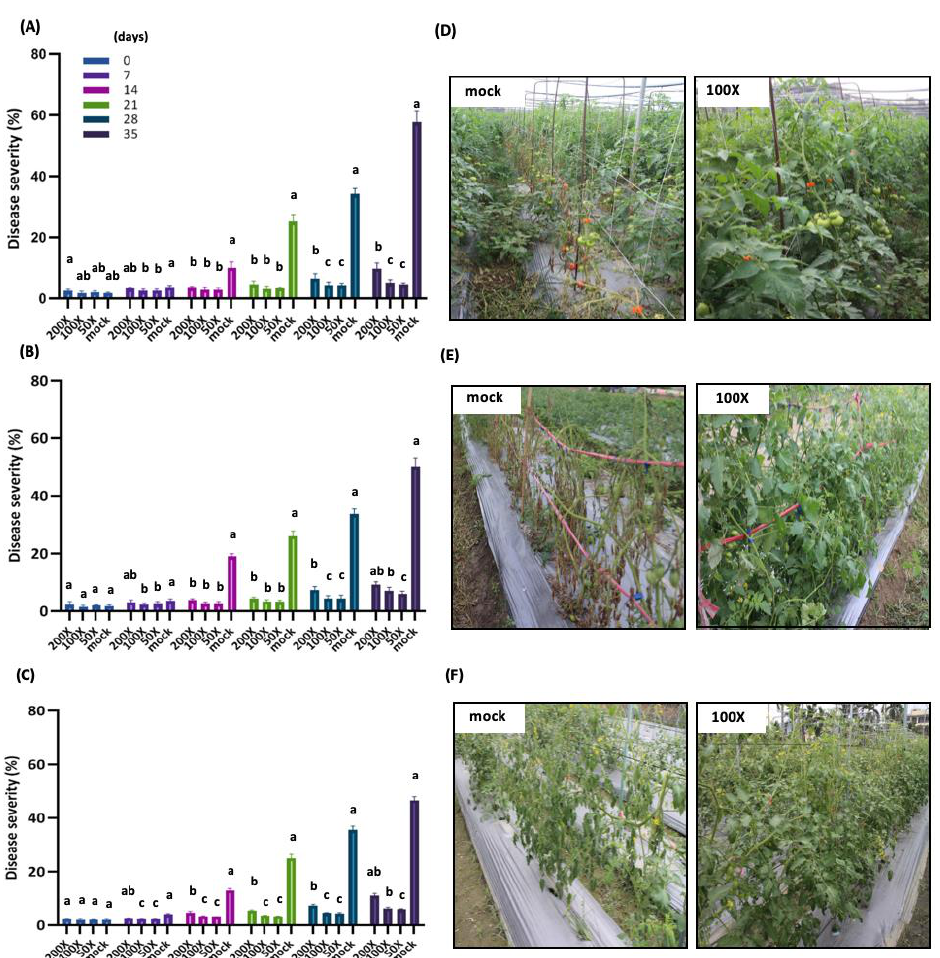
Figure 5. Field trials evidencing the Bacillus amyloliquefaciens PMB01 strain’s effectiveness in con- trolling bacterial wilt disease in three tomato farms. Bacterial wilt disease caused by Ralstonia solanacearum occurred regularly in these farms. ( A ) The disease severity of bacterial wilt on TMB-688 tomato variety planted in Ren-Wu District in 2014. ( B ) The disease severity of bacterial wilt on Yu Nu tomato variety grown in A-Lian District in 2015. ( C ) The disease severity of bacterial wilt on Golden Sweet tomato variety grown in Mei-Nong District in 2016. Tomato plants were treated with PMB01 wettable powder (WP) at 200X, 100X, 50X, or water (mock control) every week for five consecutive weeks. Disease severity was determined on days 0, 7, 14, 21, 28 (last treatment of PMB01), and 35 in each trial. Means within the columns followed by different letters are significantly different according to Tukey’s HSD analysis ( p < 0.05). Images of tomato plants after being treated with water (mock) or PMB01 wettable powder at 100X on day 35, showing the effectiveness of PMB01 in controlling bacterial wilt in tomato farms located in Ren-Wu ( D ), A-Lian ( E ), and Mei-Nong ( F ) districts. In these three farms, plants treated with water only (mock) showed severe wilting, whereas plants treated with PMB01 WP (100X) were healthy in three locations.